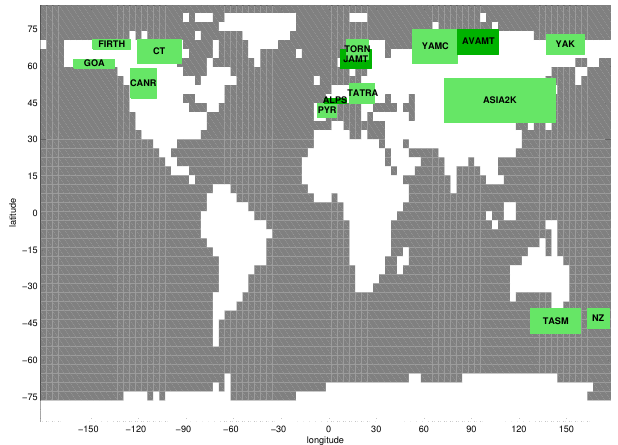
Figure 2. Location of regions that the 15 tree-ring records represent, plotted on the land/sea mask of the MPI-ESM model. Regions’ short names are explained in Table 1.